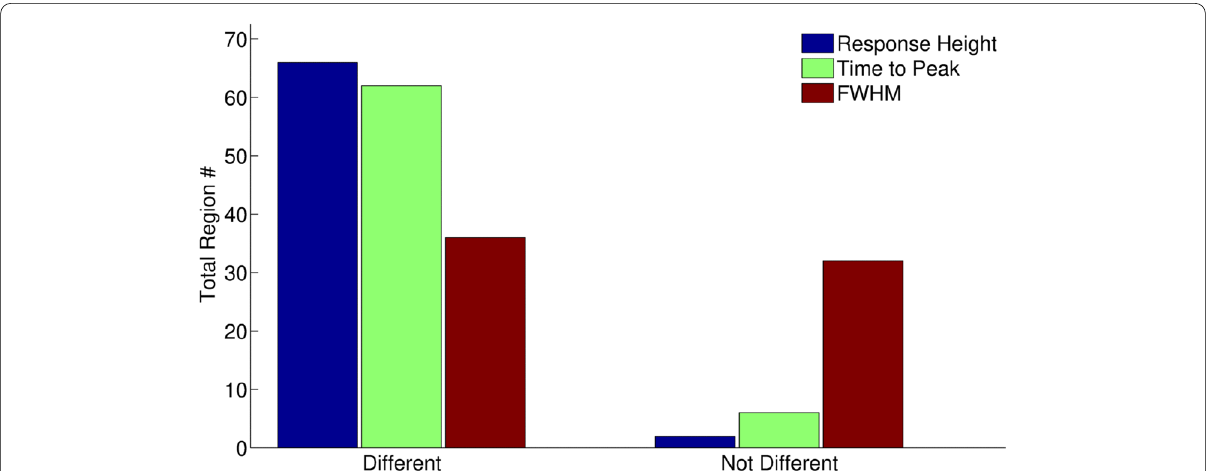
Fig. 6 Summary of one-way ANOVA analysis performed on HRF parameters (response height, time to peak, and FWHM) for 68 regions. 66 out of 68 region had significant difference across the layers for the response height, 62 out of 68 regions for time to peak, and 36 regions for FWHM at p (corrected) < 0.05